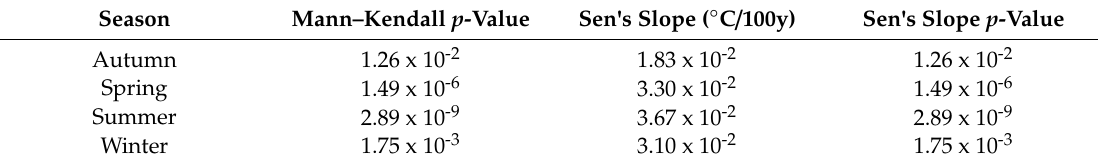
Table 3. Trend analysis of long-term temperature data for the period 1951–2019. A Mann–Kendall p-value of < 0.05 indicates a significant trend. Sen’s slope is a value of that trend. A Sen’s slope p-value of < 0.5 indicates a significant value of a trend.